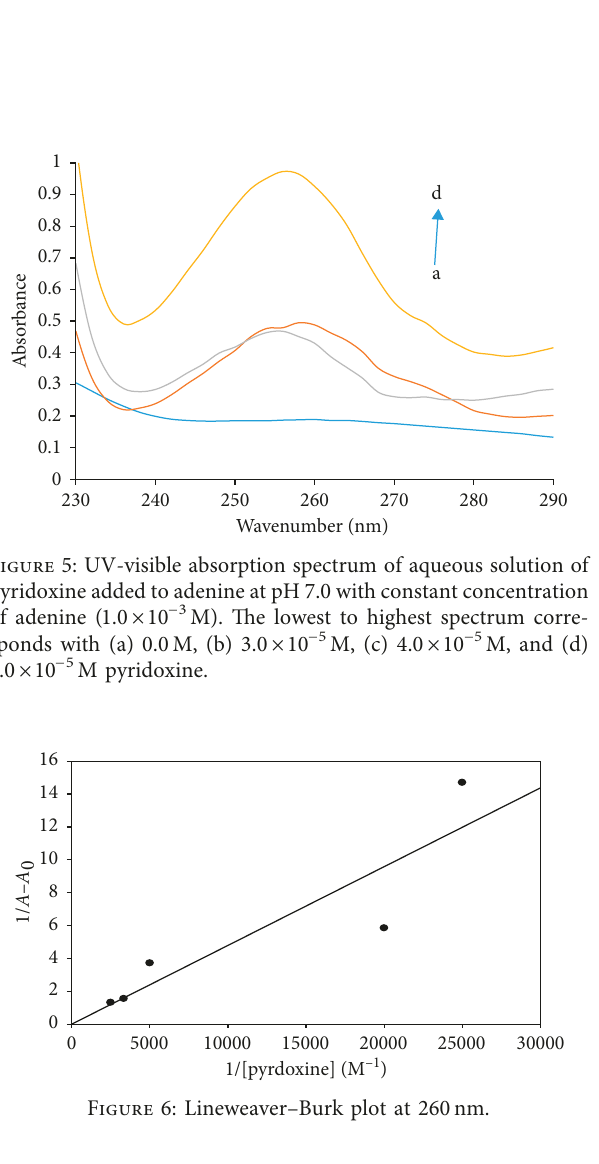
Figure 6: Lineweaver–Burk plot at